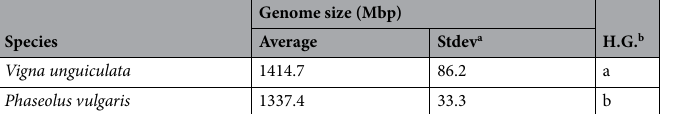
Table 1. Comparison of the average genome size of the Phaseolus vulgaris and Vigna unguiculata accessions estimated by flow cytometry. a Standard deviation. b Homogeneous groups: accessions sharing the same letter for each mineral are not statistically different according to the Scott-Knott test at 5% of